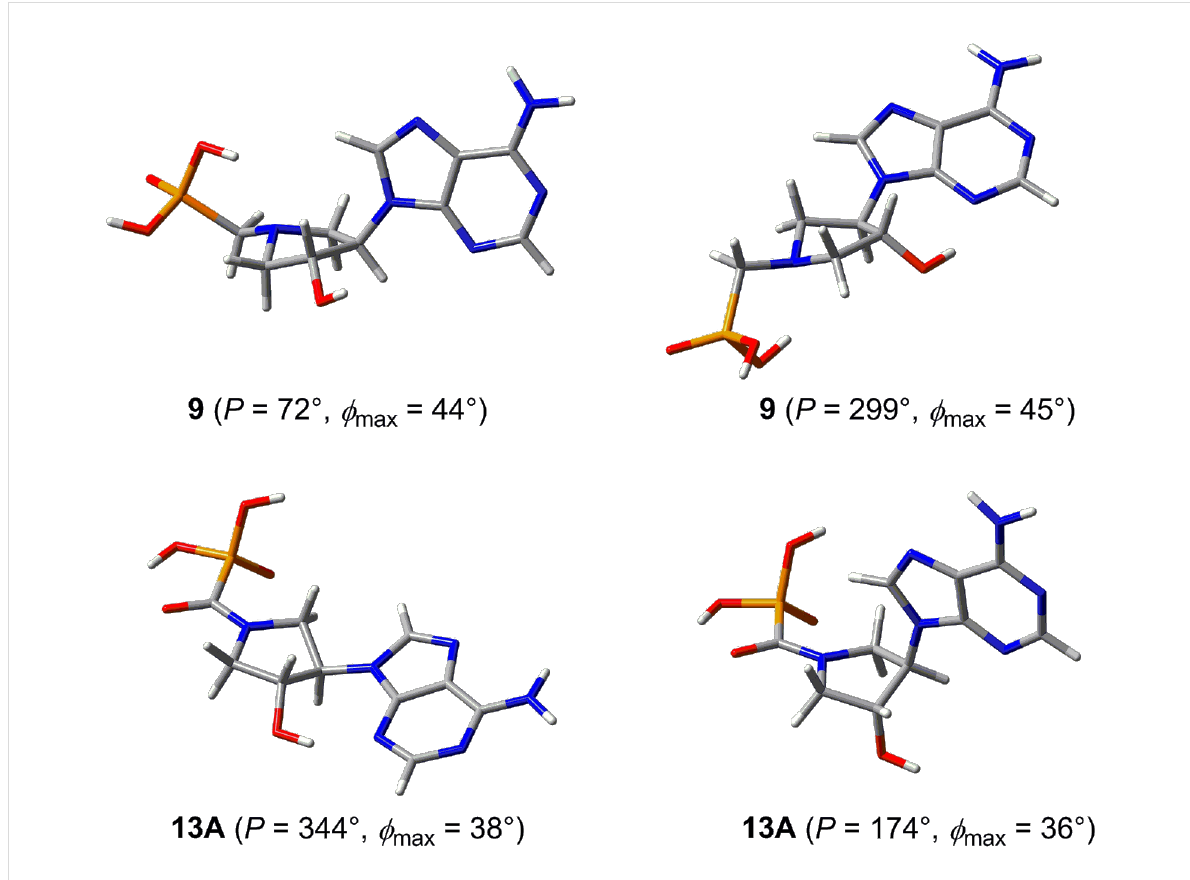
Figure 14: The most stable conformations of adenine derivatives 9 and 13A calculated by the B3LYP/6-31++G* method in water (CPCM).